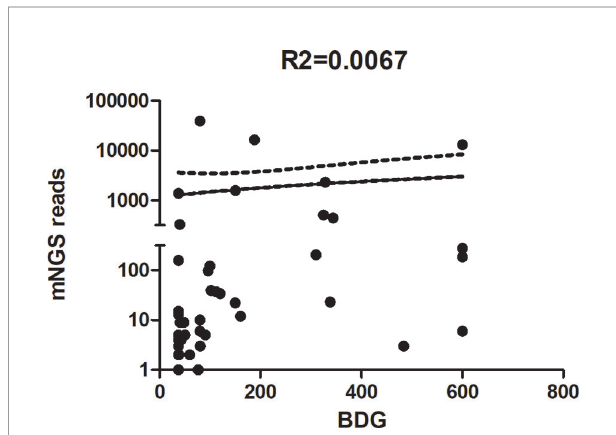
FIGURE 4 | Scatterplot between reads of metagenomic next-generation sequencing (mNGS) and the 1,3- b -D-glucan titre in mNGS-positive patients.